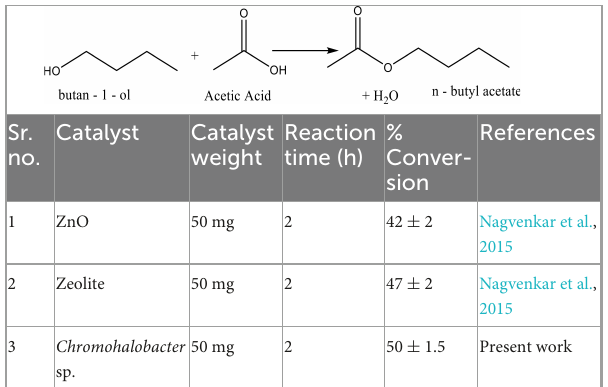
TABLE 4 Comparative table of various catalysts used for esterification reaction of butan-1-ol with CH 3 COOH.